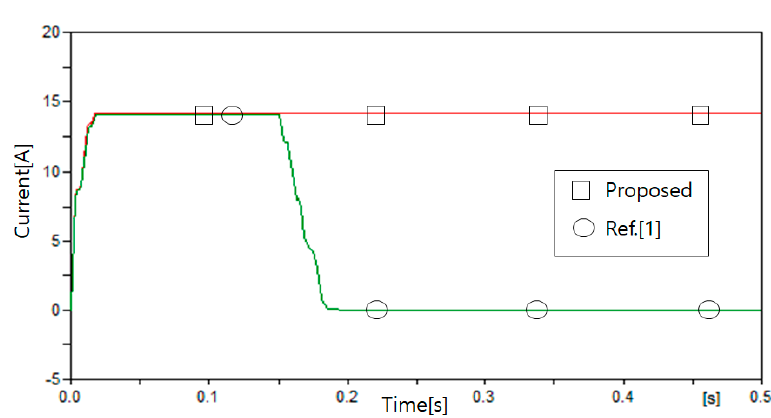
Figure 21. Current measured at Load 6 in Case 5.